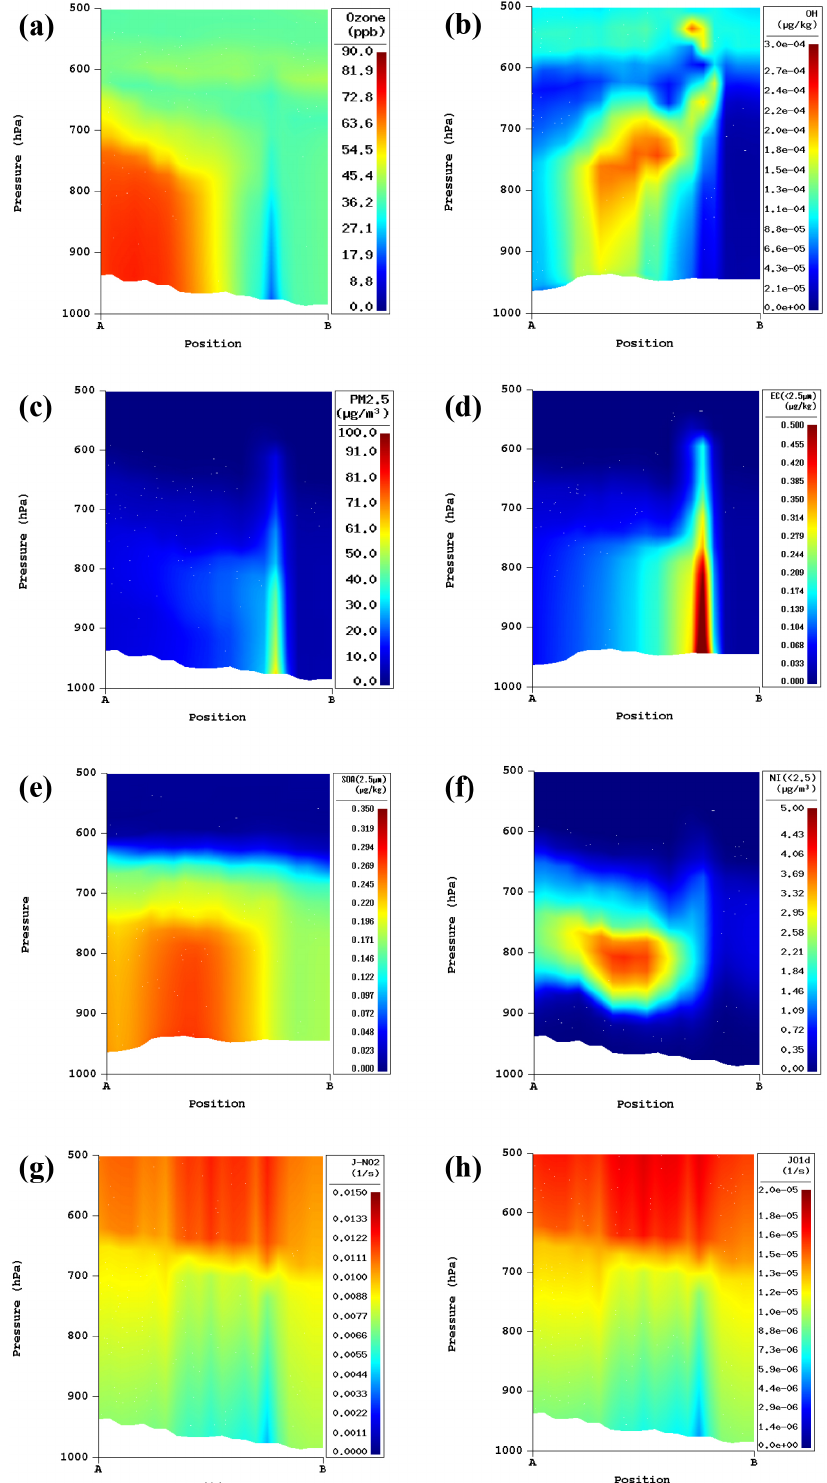
Figure 15. Cross sections of gas and aerosol concentrations and photolysis rates with aerosol feedbacks over the line shown in Fig. 14c, Lac La Loche forest fire on 25 June 2018 at 23:00UTC: (a) ozone (ppb), (b) hydroxyl radical (µgkg − 1 ), (c) PM 2 . 5 (µgm − 3 ), (d) EC ( < 2 . 5µm, µgkg − 1 ), (e) nitrate ( < 2 . 5µm, µgm − 3 ), (f) SOA ( < 2 . 5µm, µgkg − 1 ), (g) J (NO 2 ) (s − 1 ), (h) J (O 1 D) (s − 1 ).